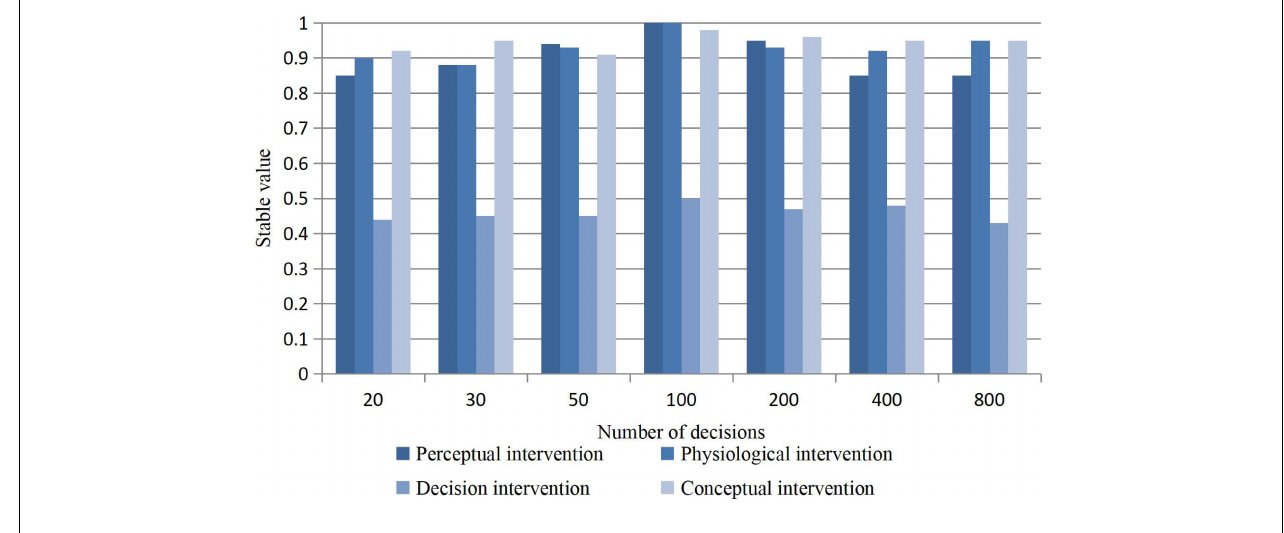
FIGURE 7 | Influence of the number of decisions on the stability of intervention.